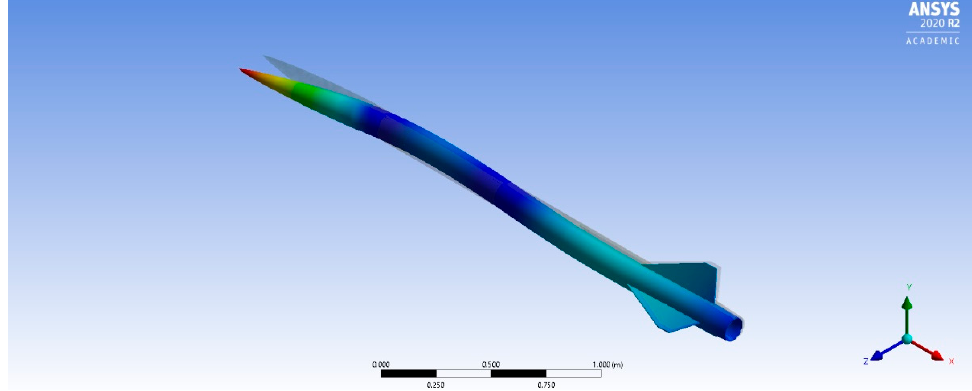
Figure 28. First-Order Bending Mode Shape (X–Y Plane).